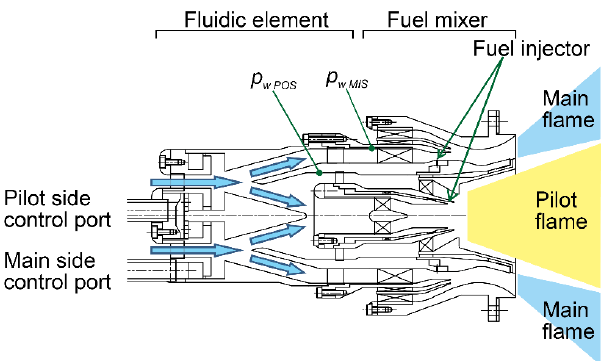
Figure 2. Lean staged burner with the fluidic element. (Copyright by ASME — "Effects of Fluidic Control of Air-Flow Distribution on Staged Lean Jet Engine Burner," by Yoshida, Schneider, Hassa, Paper No: GT2016-57453). Paper No: